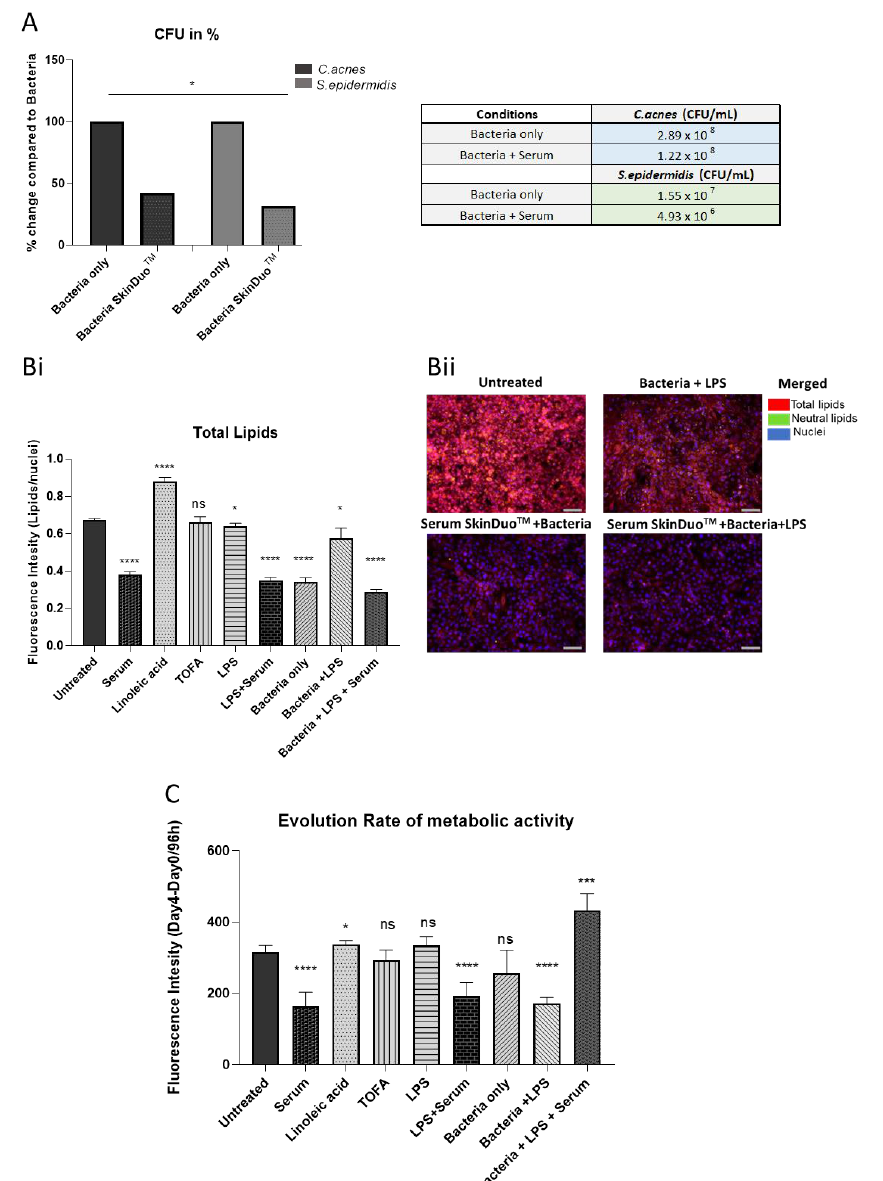
Figure 3. Ex vivo acne sebaceous gland model with virulent phylotype of C. acnes and S. epidermidis after 48 h of serum SkinDuo TM treatment. ( A ) Bacterial association with human sebocytes shows result per strain (black bar: C. acnes , grey bar: S. epidermidis ). Bacterial enumeration as CFU/mL and expressed as percentage compared to bacteria only showed a decrease in CFU/mL after serum SkinDuo TM treatment, * p < 0.05. ( Bi ) Conditions tested in 2D human sebocytes for the following: untreated (basal), serum (SkinDuo TM ), linoleic acid (positive control for lipid production), TOFA (5-(tetradecyloxy)-2-furoic acid), negative control that reduces fatty acids synthesis and induces inhibition, LPS (lipopolysaccharide) induces an inflammatory challenge; serum in the presence of bacteria ( C. acnes , S. epidermidis ) and challenged with LPS. The in vitro cellular model challenged with LPS in the presence of bacteria and treated with serum SkinDuo TM significantly reduced total lipid production when compared to bacteria and challenged with LPS. At baseline, the in vitro cellular model treated with serum decreased lipid production. Fluorescence intensity measurement as a ratio of total lipids/nuclei. ( Bii ) Lipid production analysis was measured with a fluorometer (TECAN) in each well when stained with Hoechst for nuclei ‘DAPI’, Nile Red for neutral lipids ‘FITC’ and total lipids ‘TRITC’, presented as merged picture,